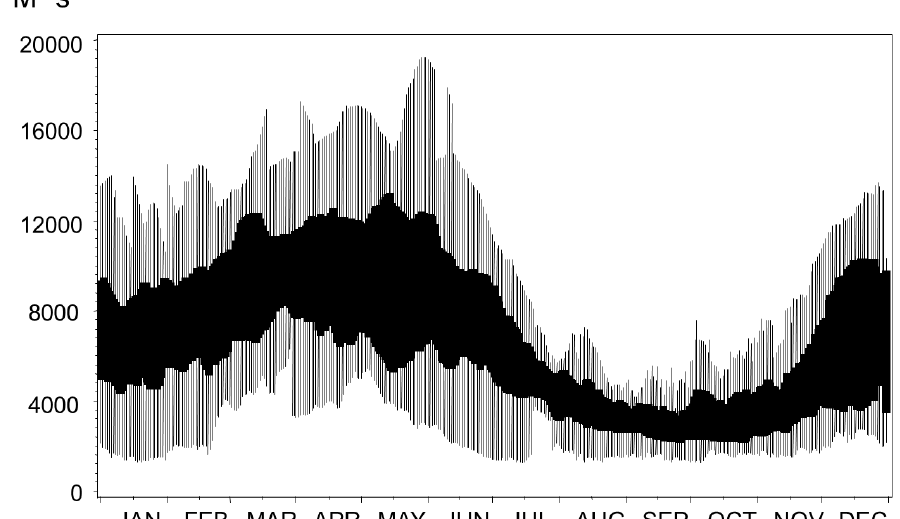
Figure 2. Seasonal trend of discharge into the Atchafalaya. The solid area represents discharge within 25th–75th percentiles, and the vertical lines represent maximum and minimum daily